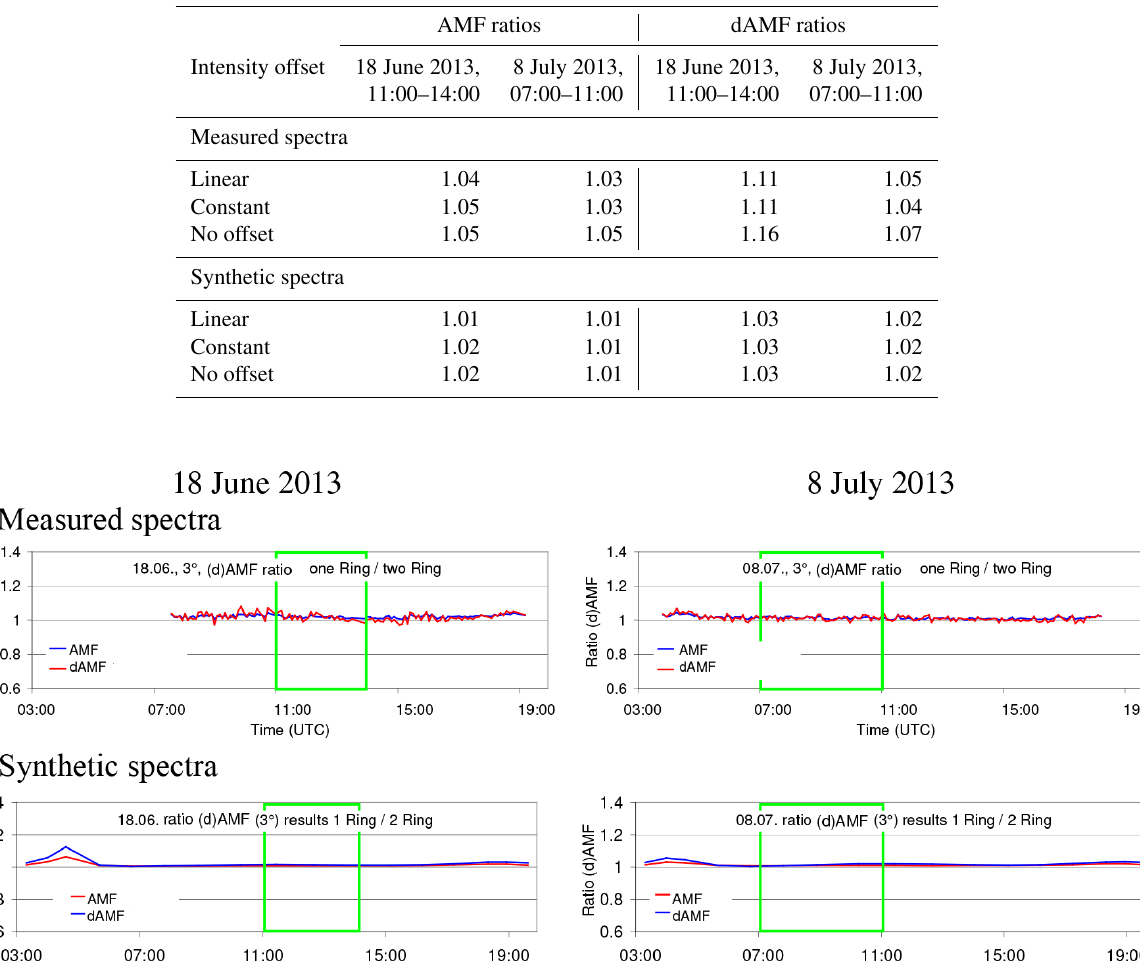
Figure A18. Ratios of the O 4 (d)AMFs derived for the analysis with only one Ring spectrum vs. those for the standard analysis (using two Ring spectra) for both selected days ( a : results for spectra measured by the MPIC instrument; b : results for synthetic spectra when taking into account the temperature dependence of the O 4 cross